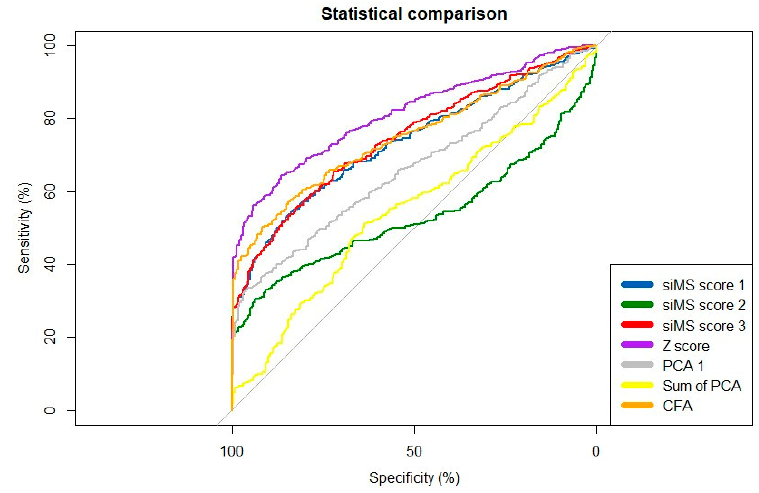
Figure 2. ROC curves for the continuous metabolic syndrome scores as discriminators of metabolic